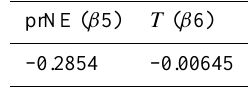
Table A1. Coefficients for the function (1).